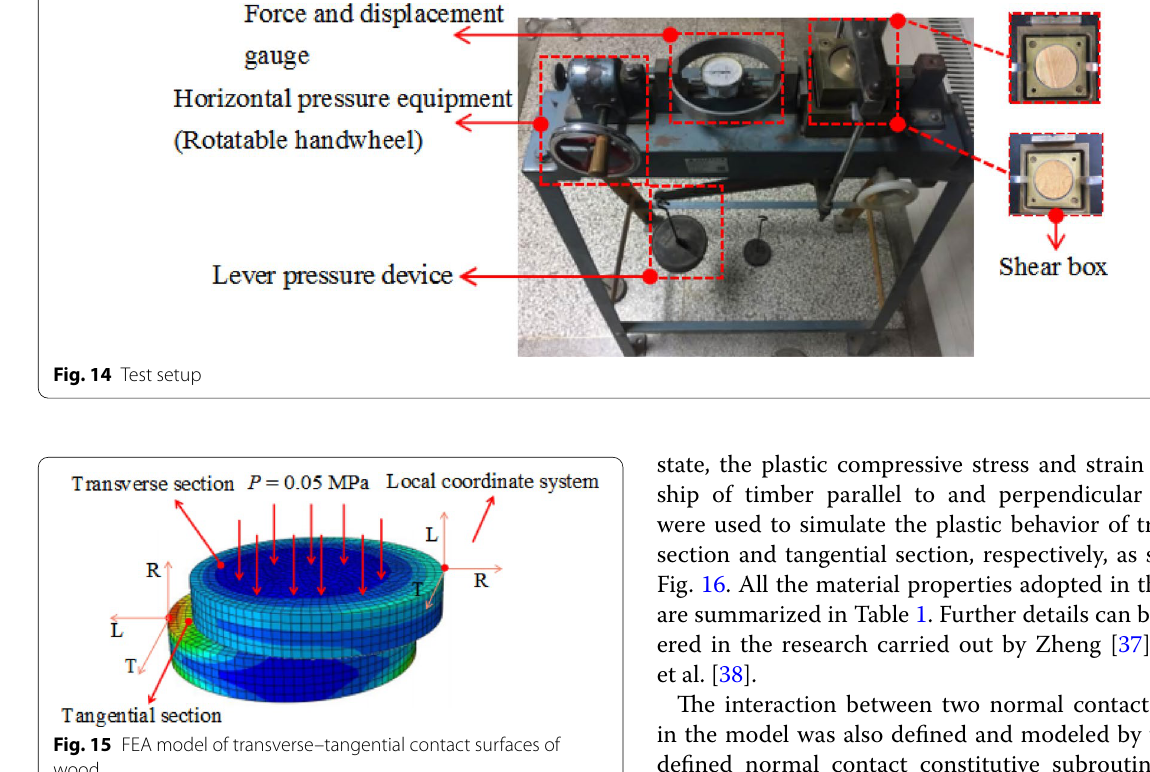
pressure of 0.05 MPa was applied to the top surface of the specimen, the shearing process between contact surfaces was controlled by displacement; the FEA model of trans- verse–tangential contact surface of wood is illustrated in Fig. 15. The elasticity constants were used to character- ize the orthotropic anisotropy of wood under the elastic